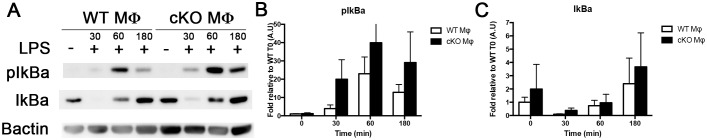
Irf6 inhibits NFkB activation in bone marrow-derived macrophages in vitro.(A) Western blot analysis (one representative of 3 experiments) for pIkBa, IkBa and Bactin of wild-type (WT) and Irf6 cKO (cKO) macrophages (MΦ) unstimulated or stimulated with LPS for 30, 60 and 180 min. (B, C) Quantitative analysis of three independent Western blot analysis as presented in (A) expressed as fold change from the unstimulated (T0) control cells.